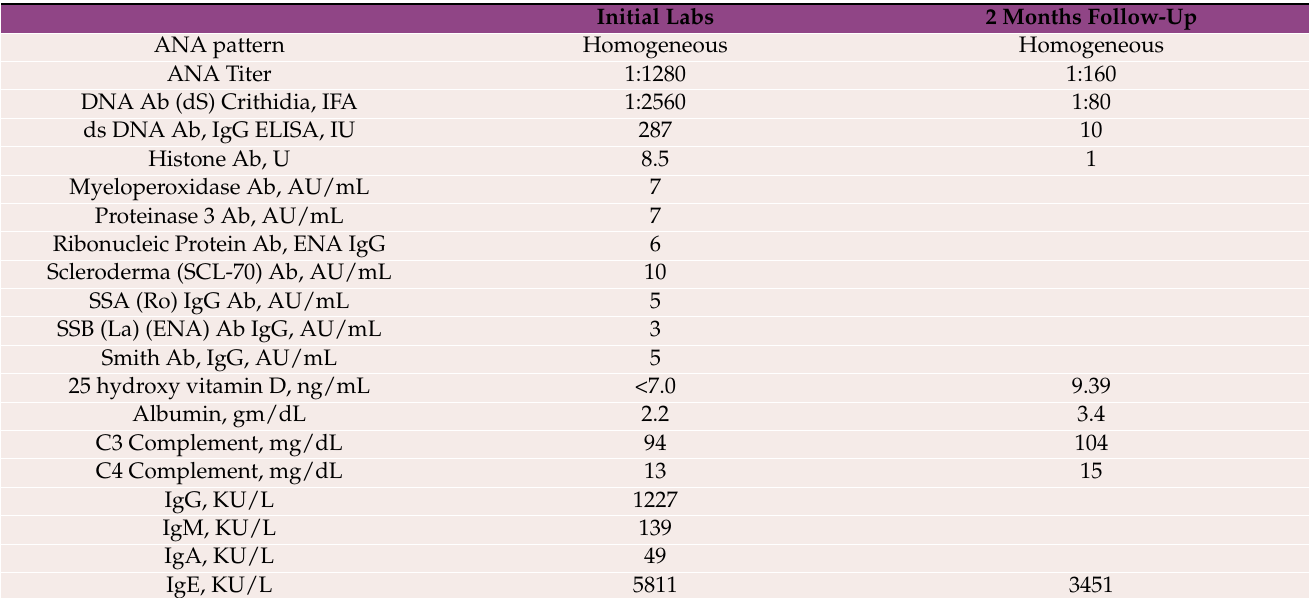
Table 2. Laboratory values. ANA, antinuclear antibody; Ab, antibody; ds, DNA, deoxyribonucleic acid; double-stranded; ELISA, enzyme-linked immunosorbent assay; ENA, extractable nuclear antigen; IFA, immunofluorescence assay; Ig, immunoglobulin. Initial Labs 2 Months